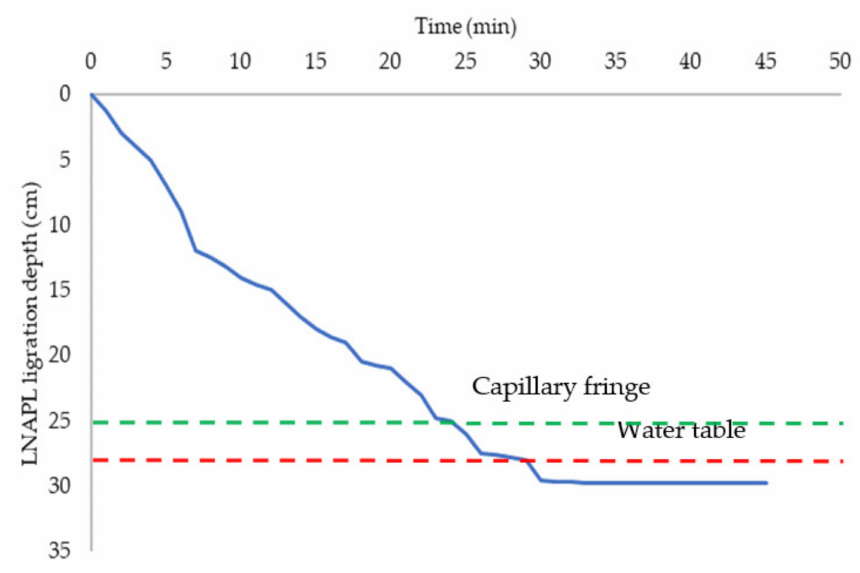
Figure 2. The behavior of 50 mL diesel volume in capillary fringe and water